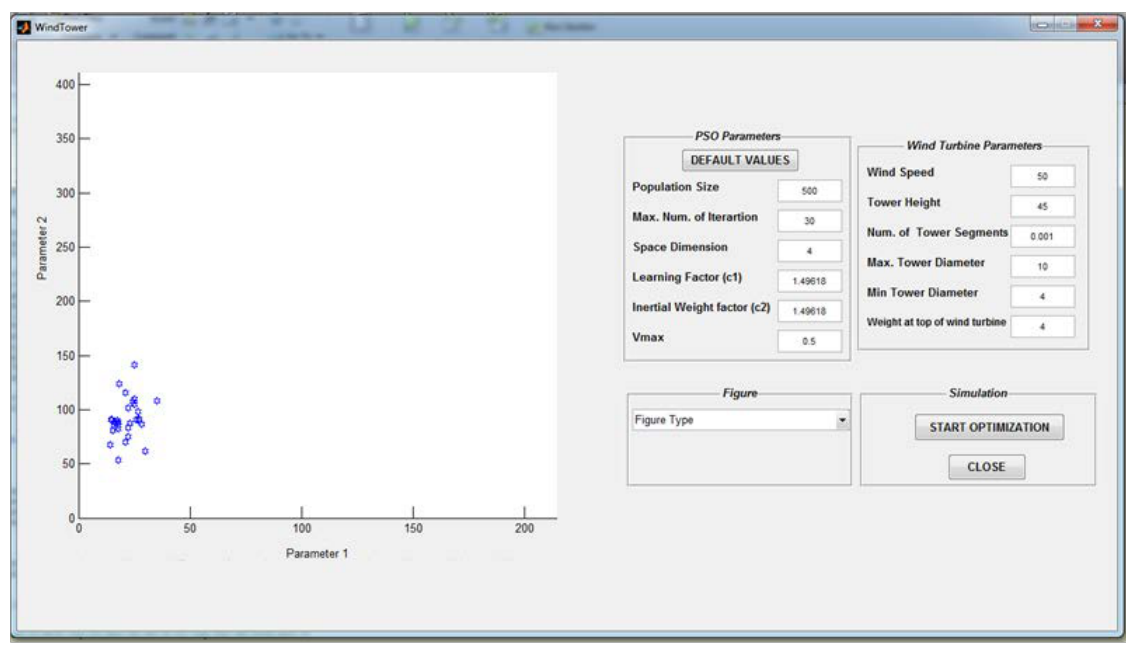
Figure 5. A view of the developed computer